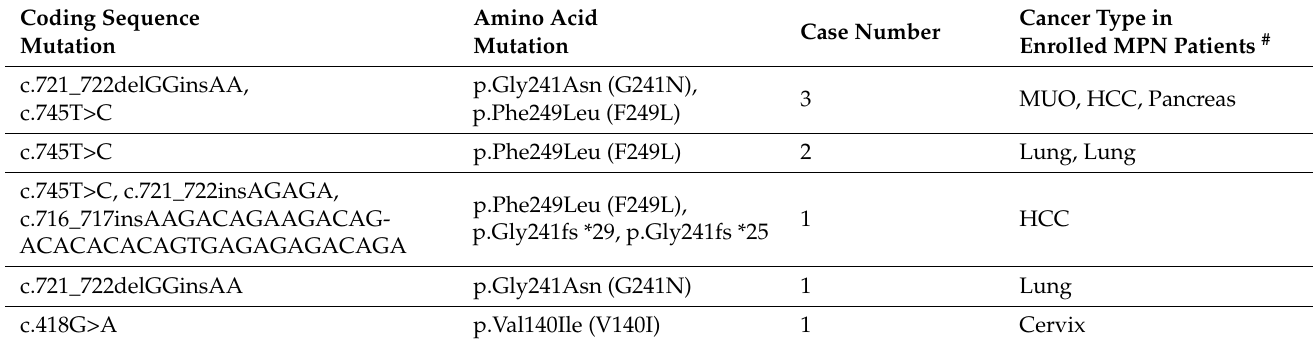
Table 2. Variants of the KRT6A gene identified in our MPN patients with second cancers.